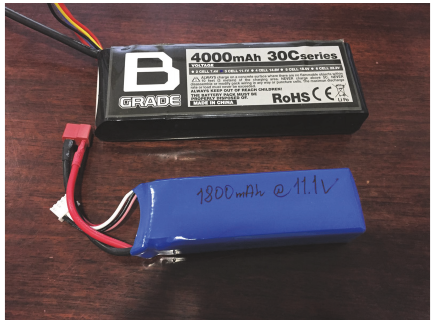
Figure 4: LiPo battery packs used in research tests.